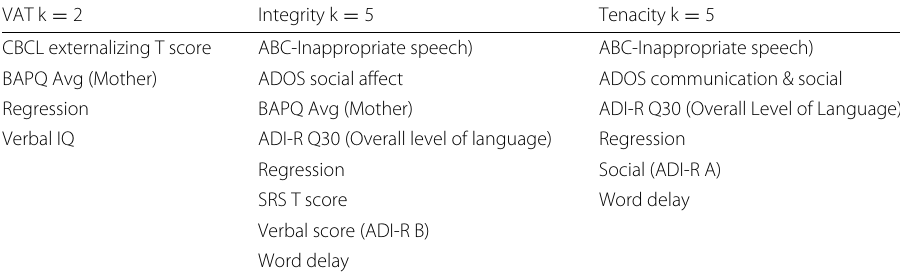
Table 9 Set of discriminant features by clustering result for no node reassignment VAT k =